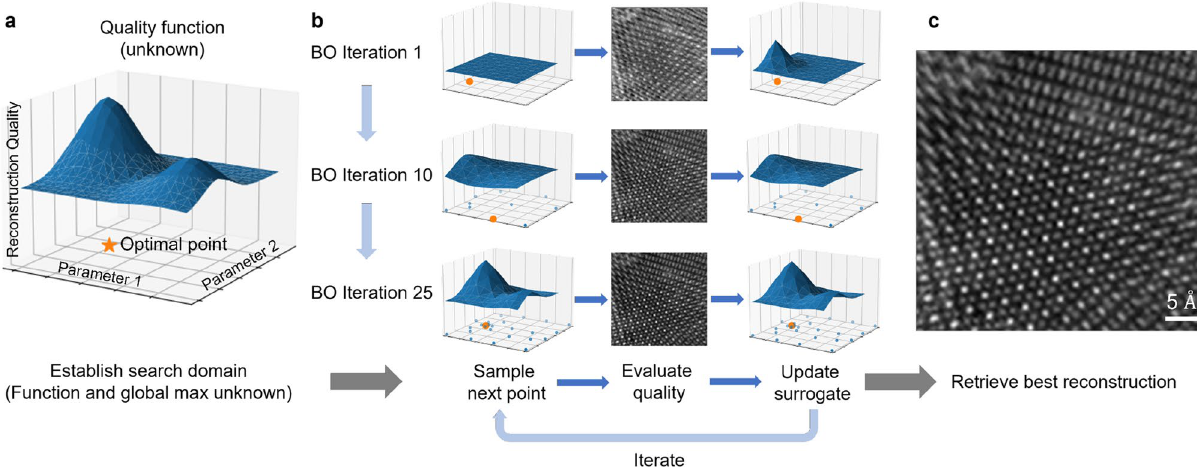
Figure 1. Schematic of automatic reconstruction tuning with Bayesian optimization. ( a ) The process aims to find the best ptychographic reconstruction by optimizing an unknown quality function that is data-dependent in general. ( b ) Bayesian optimization loop strategically determines the next point (indicated in orange) to sample, performs ptychographic reconstruction, and then updates the surrogate model based on the image quality. As the number of iterations increases, the surrogate model becomes closer to the true quality function and more points around the optimum are exploited. ( c ) The image with the best quality during BO is retrieved as the final